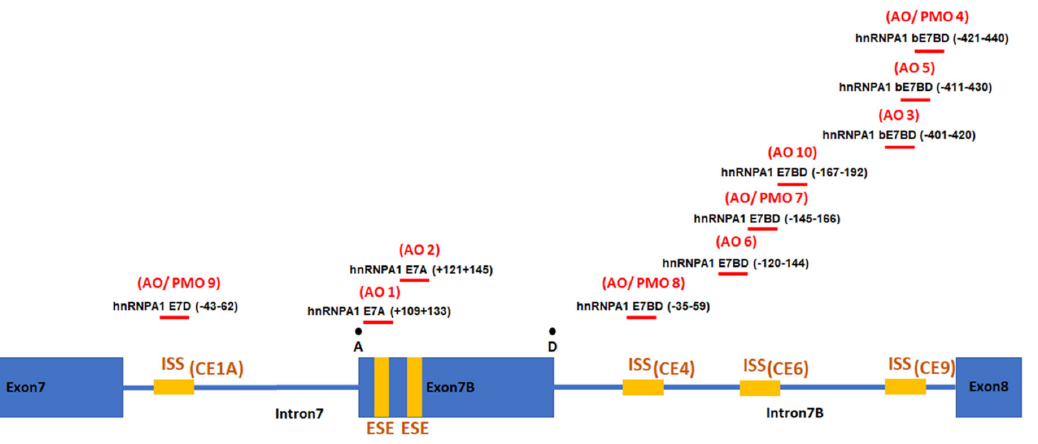
Figure 1. Schematic diagram displaying the targeting splice motifs and AO coordinates of ten AOs induced hnRNPA1 exon 7b skipping (AOs1 and 2) and inclusion (AOs3–10).